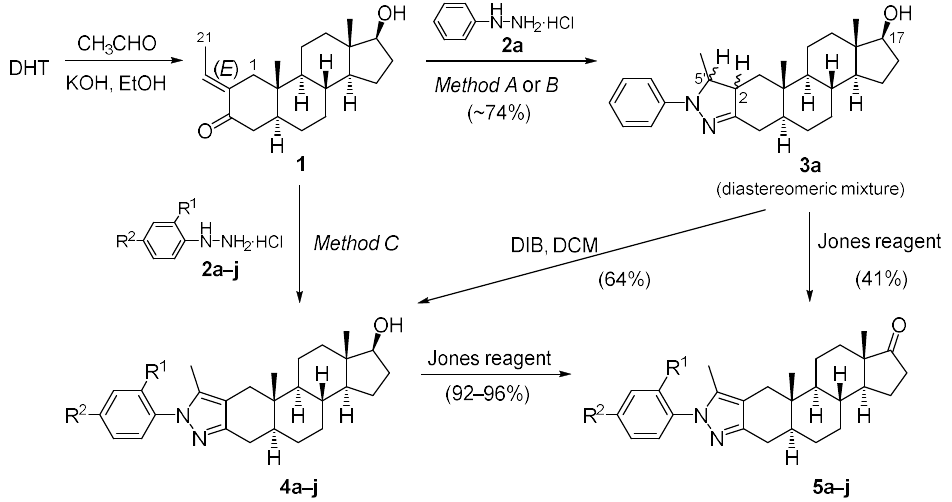
Scheme 1. Synthesis of ring A-fused arylpyrazole derivatives of DHT. Reagents and conditions: Method A: p-toluenesulfonic acid (PTSA) (0.5 equiv.), EtOH, reflux, 78 ◦ C, 1 h; Method B: PTSA (0.5 equiv.),